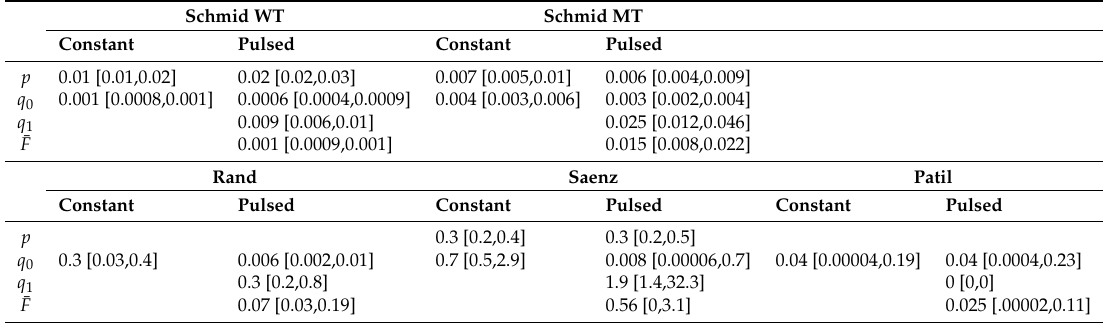
Table 7. Parameters for datasets in effective units. Effective units allow for comparison of the IFN response across datasets. We define IFN effective units (iEU) and viral effective units (vEU) as the extracellular IFN concentration and virion concentration, respectively, necessary to reduce target